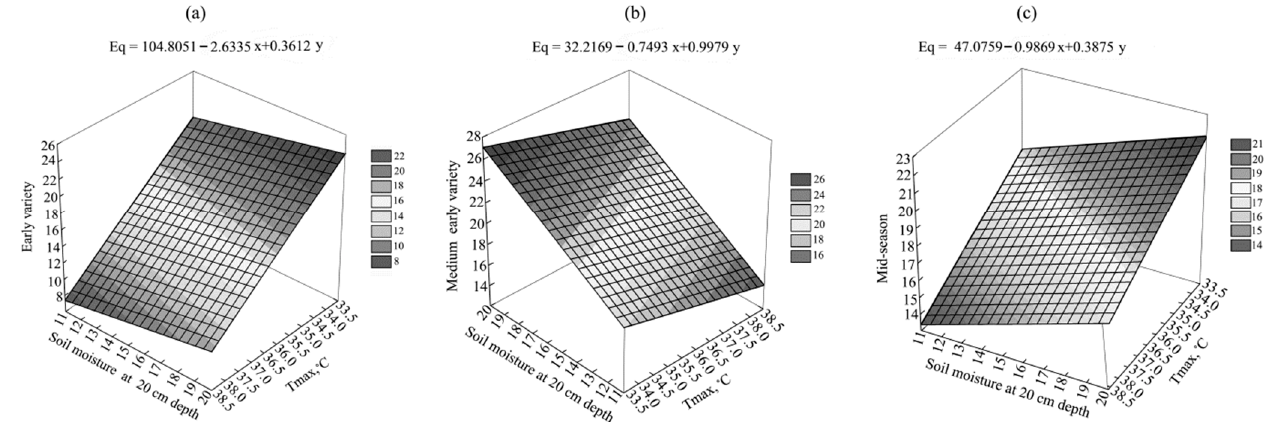
Figure 6. Linear surfaces of distribution of yield parameters of early variety ( a ), medium-early variety ( b ) and mid-season ( c ) potato varieties in the space of hydrothermal factors.